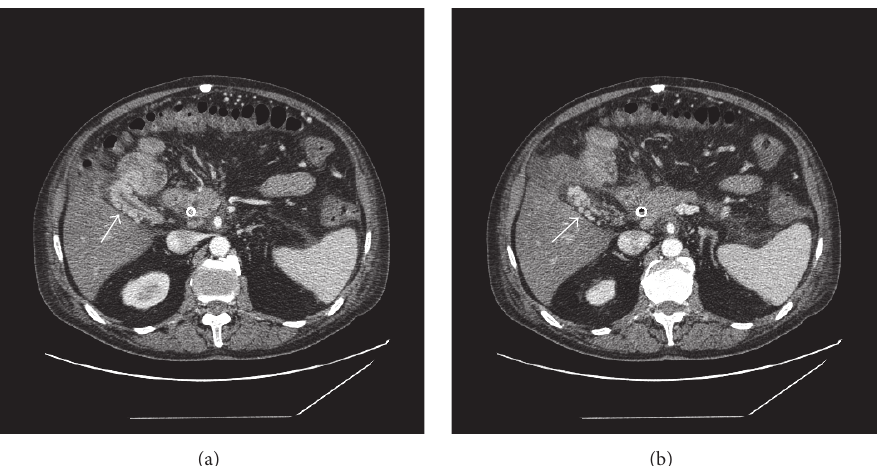
Figure 1: Abdominal contrast-enhanced CT, axial plane, showing gallbladder varices (diffuse variceal dilation of veins in the gallbladder wall).